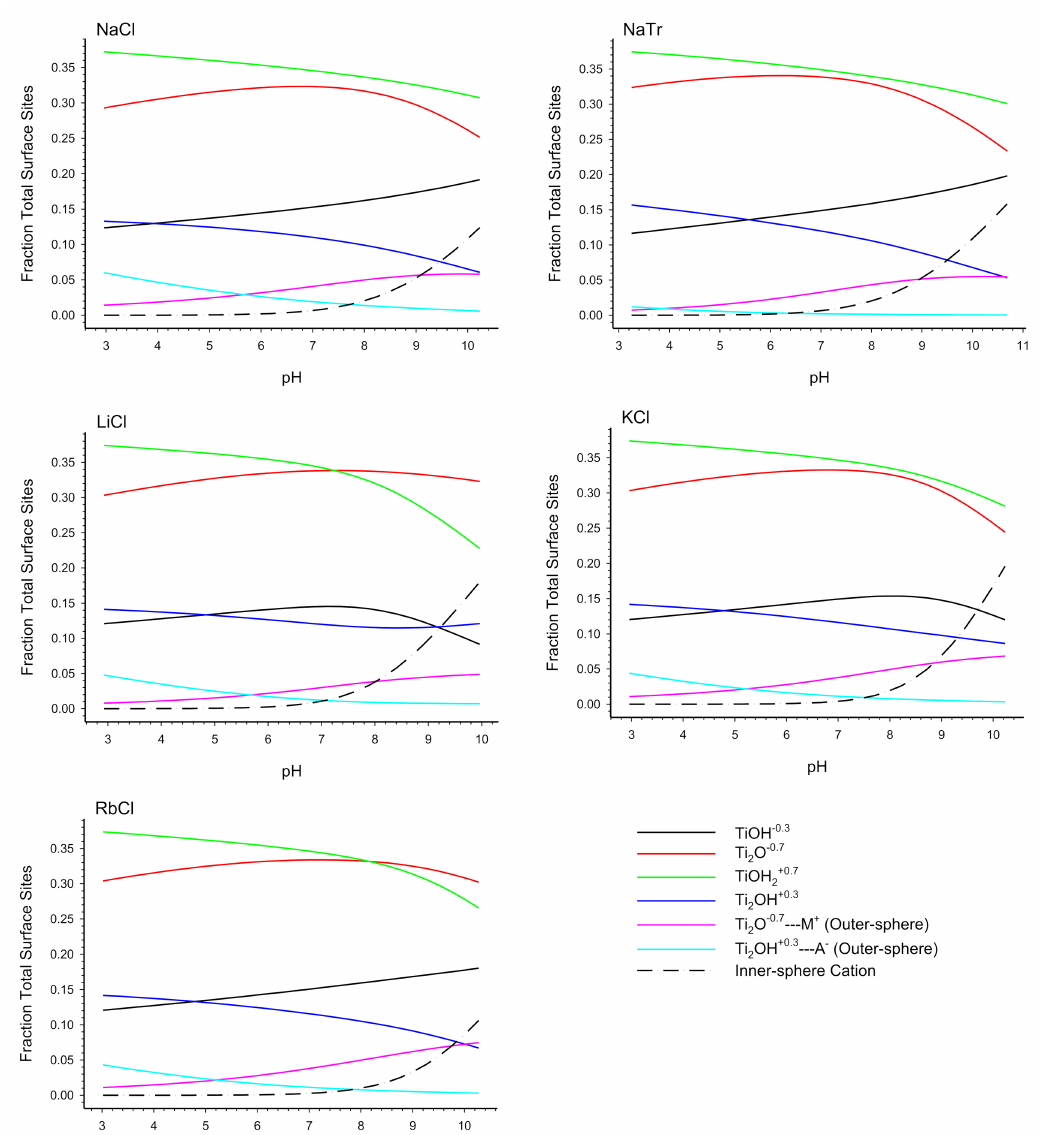
Figure 5. Distribution of surface species on the 4 nm sized anatase sample, at 0.3 m ionic strength. The inner-sphere species are described in the